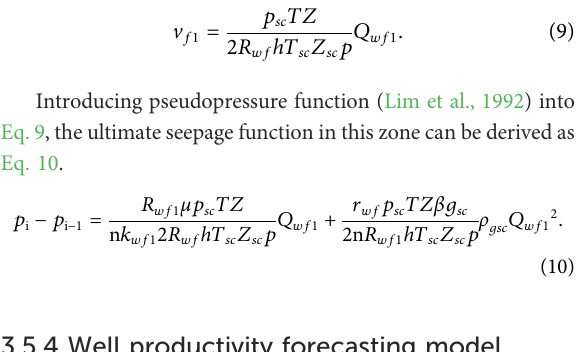
FIGURE 3 Core test and corresponding measured rock mechanical